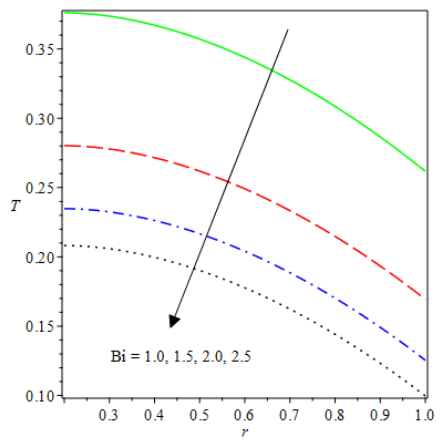
Figure 13. Heat transfer for rising ( n ) .